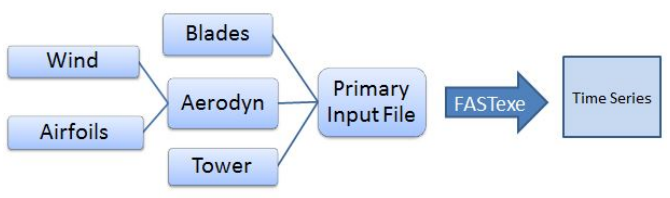
Figure 4. Flowchart for a FAST (Fatigue, Aerodynamics, Structures, and Turbulence) v7